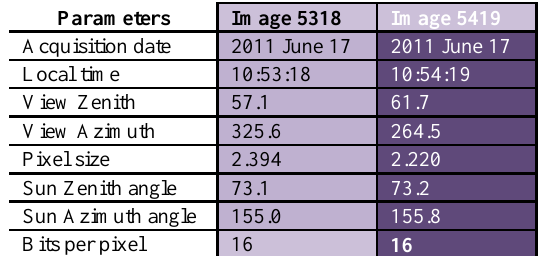
Figure 2. Distribution of the Areas of calibration in the 5419 scene Table 1: Characteristic of the WorldView2 stereo pairs images